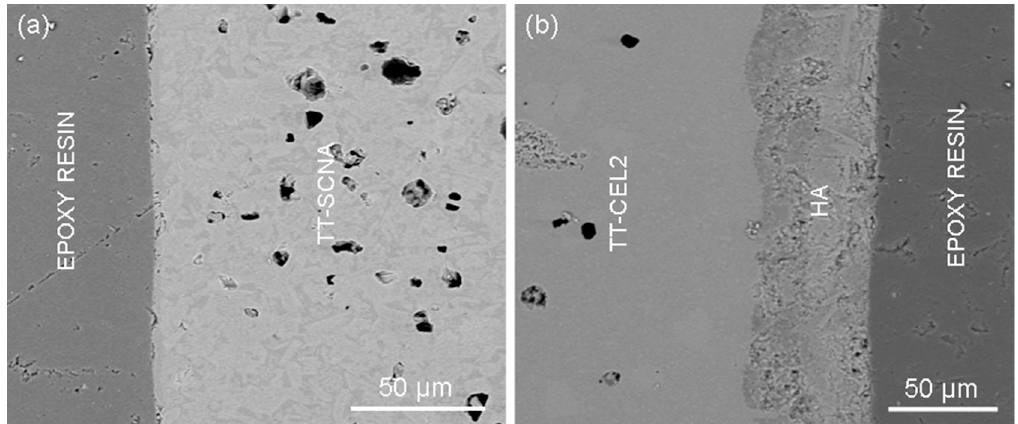
Figure 8. Cross-sections of a bilayered implant after soaking for seven days in SBF: ( a ) TT-SCNA region and ( b ) TT-CEL2 region. Appl. Sci. 2017 , 7 , 1330